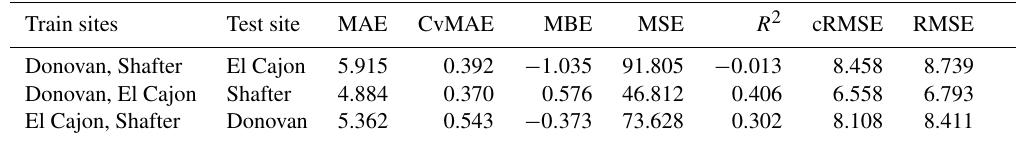
Table D5. Test results for split-NN Level 2, size 3 (NO 2 ).